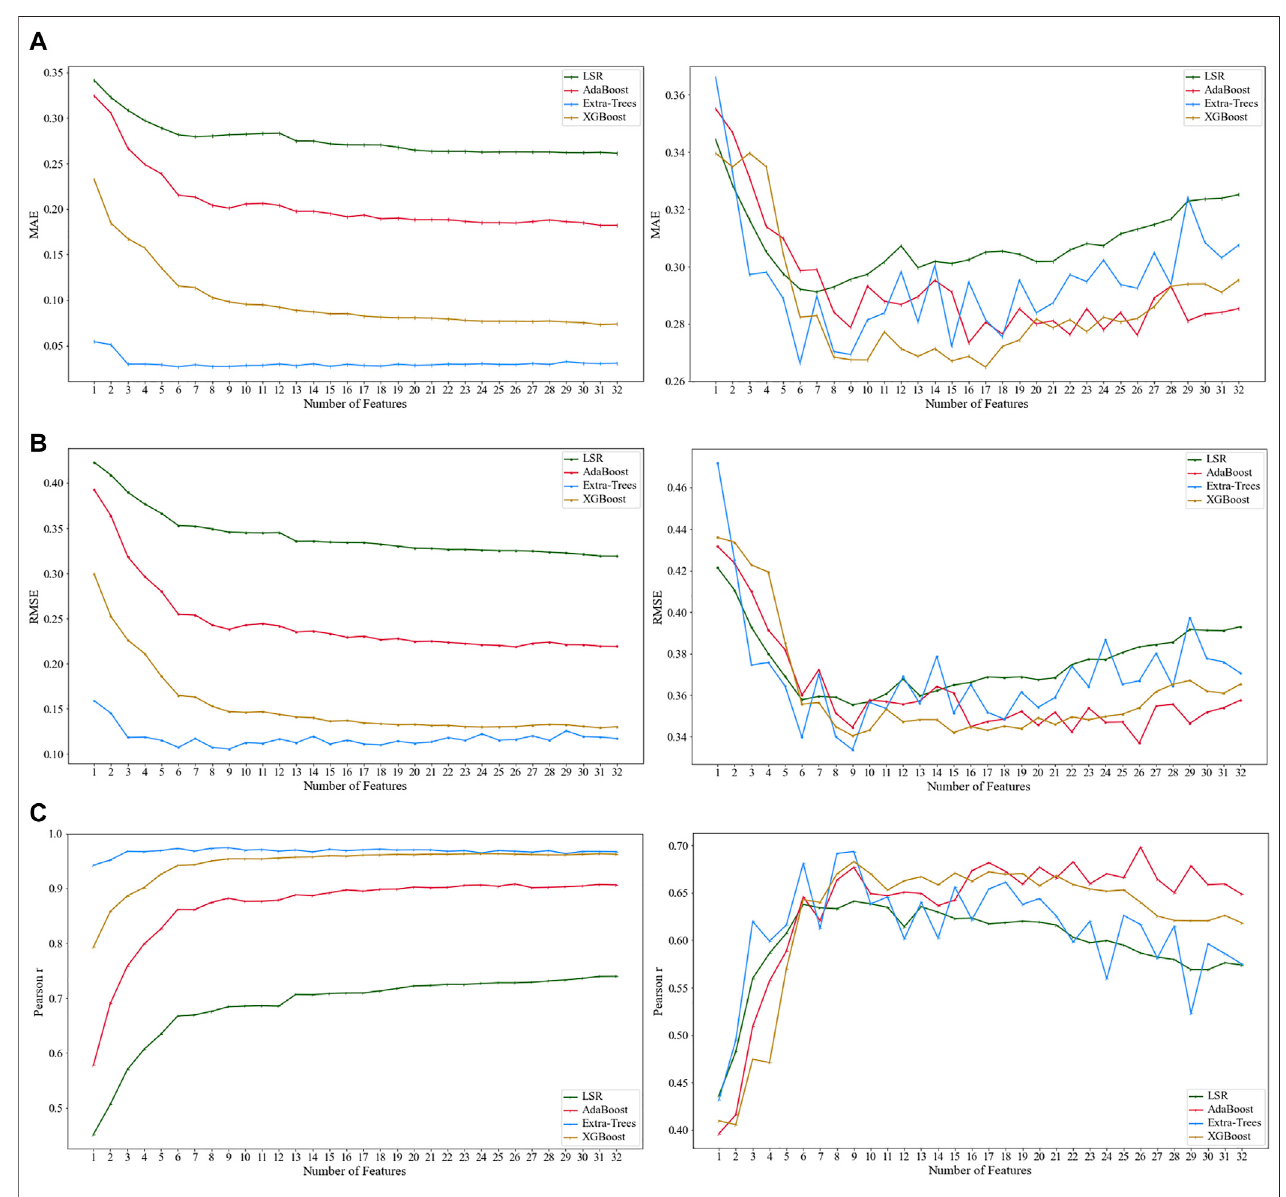
FIGURE 8 | Results from the total sample by using XGBoost regression, ExtraTrees regression, AdaBoost regression, and linear regression: (A1) mean absolute error (MAE); (B1) root mean square error (RMSE); and (C1) Pearson correlation coef fi cient. The results from the testing set sample by using XGBoost regression, ExtraTrees regression, AdaBoost regression, and linear regression: (A2) mean absolute error (MAE); (B2) root mean square error (RMSE); and (C2) Pearson correlation coef fi cient.